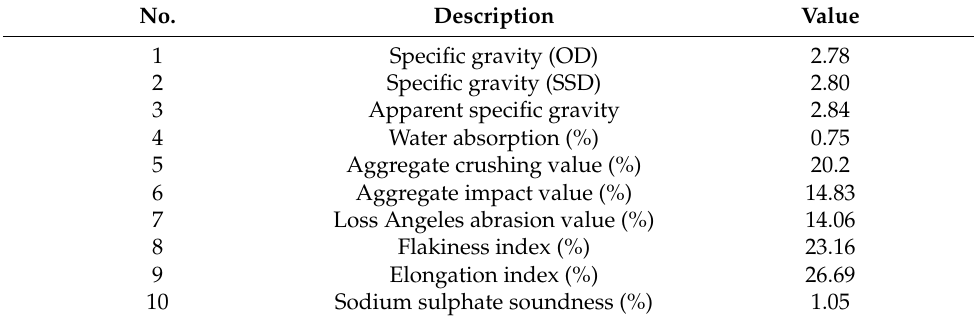
Table 3. Physical properties of natural coarse aggregates.